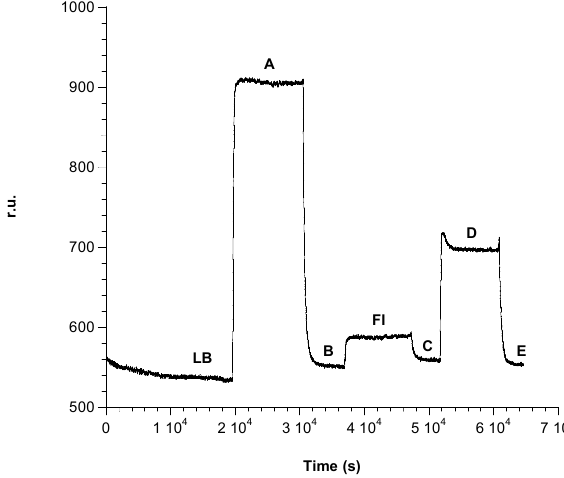
Figure 4. Immobilization of ampicillin: ( LB ) original baseline generated by flowing phosphate buffer; ( A ) activation with EDC/NHS ; ( B ) washing with phosphate buffer; ( FI ) immobilization of ampicillin 10 − 2 M; ( C ) washing with phosphate buffer; ( D ) inactivation of –COOH groups which may have not reacted with ethanolamine; ( E ) washing with phosphate buffer.